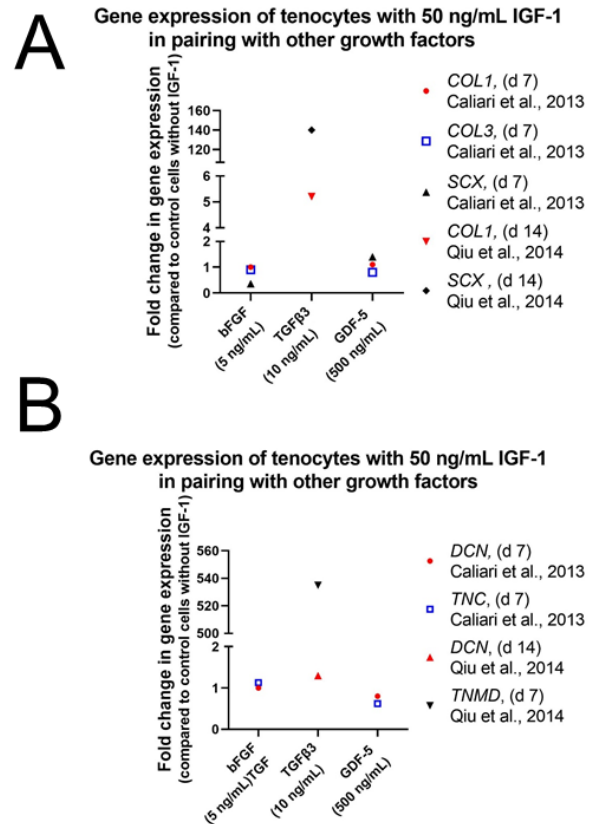
Figure 11. Impact of growth factor combinations on equine tenocytes in DMEM without FCS [82] and on human tenocytes in α -MEM without FBS [84]. Gene expression of COL1 and SCX ( A ) and DNC , TNC and TNMD ( B ) are given in fold changes.